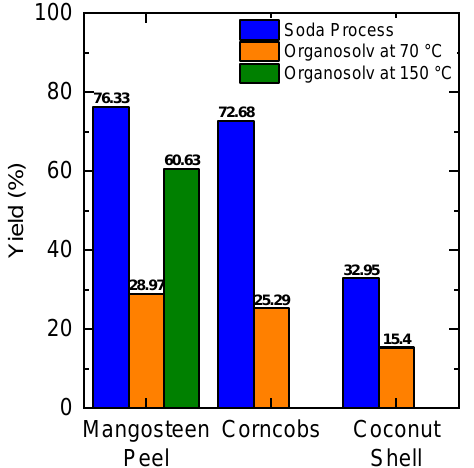
Figure 1. Yield comparison of lignin extracted using organosolv and soda processes. Data of lignin yield of mangosteen peel at 70 °C taken from our previous study [18].